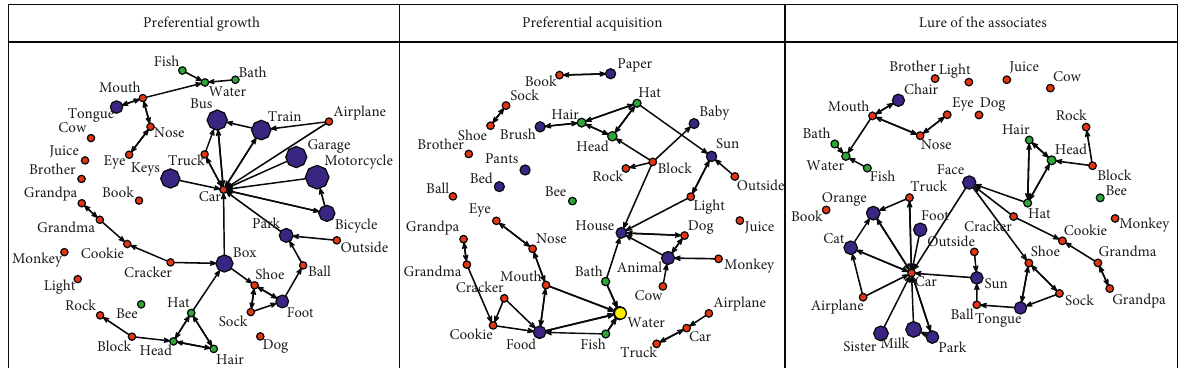
Figure 1: The three growth models with vocabulary predictions given a specific child’s vocabulary. Red words are words already known by the child, green words are words learned by the child, blue words are the 10 most likely words to be learned according to model predictions, and the yellow word (water) is a word that was correctly predicted as learned by a specific model. The size of the blue dots indicates the certainty the model gives to learning that specific